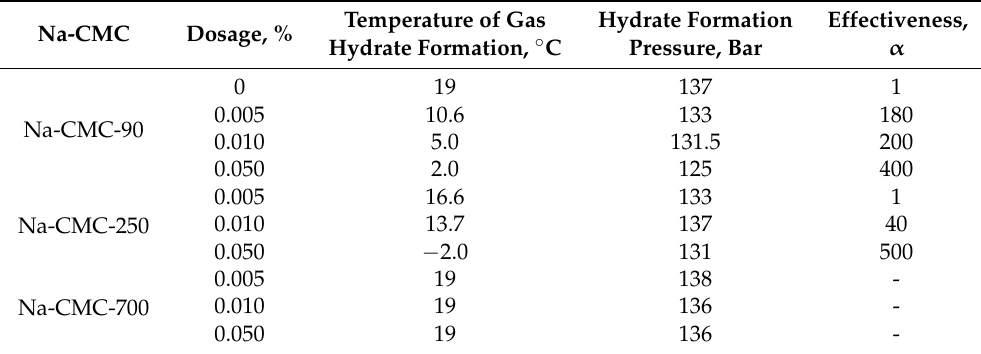
formation inhibition.